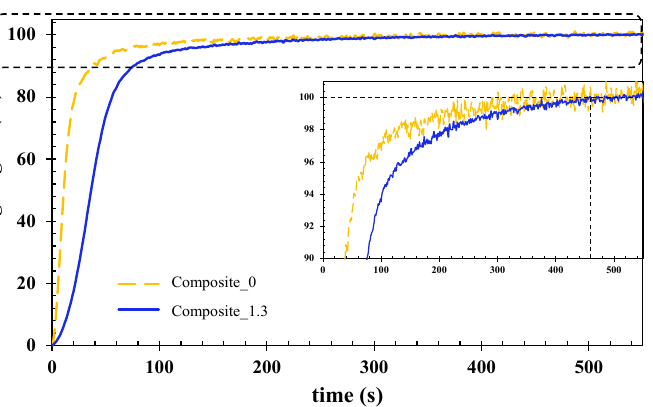
Figure 5. Curing degree evolution for unfilled composite (composite 0) and filled composite (com- posite 1.3) as a function of time 1 KHz.